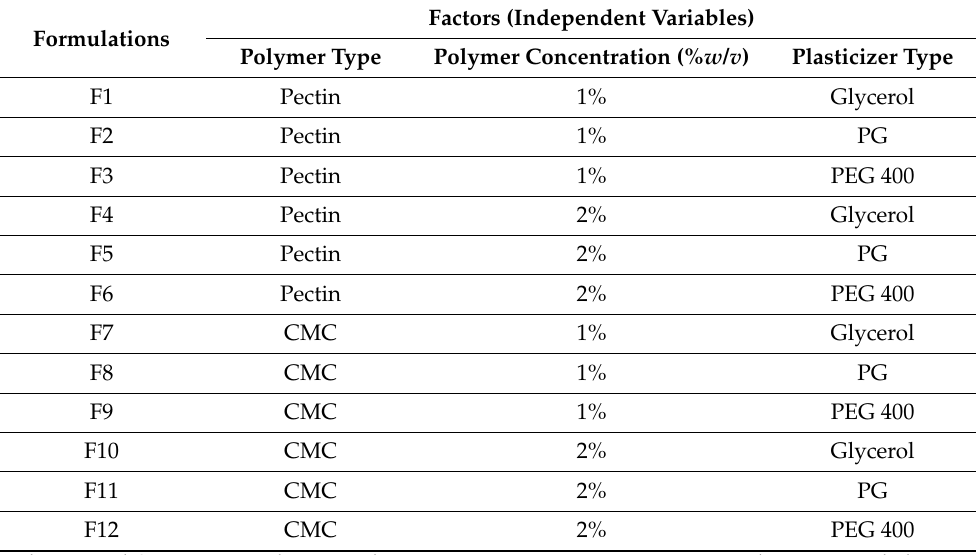
Table 1. Experimental runs and independent variables of the full factorial experimental design for the prepared OFDFs loaded with PX nanosuspension. Factors (Independent Formulations